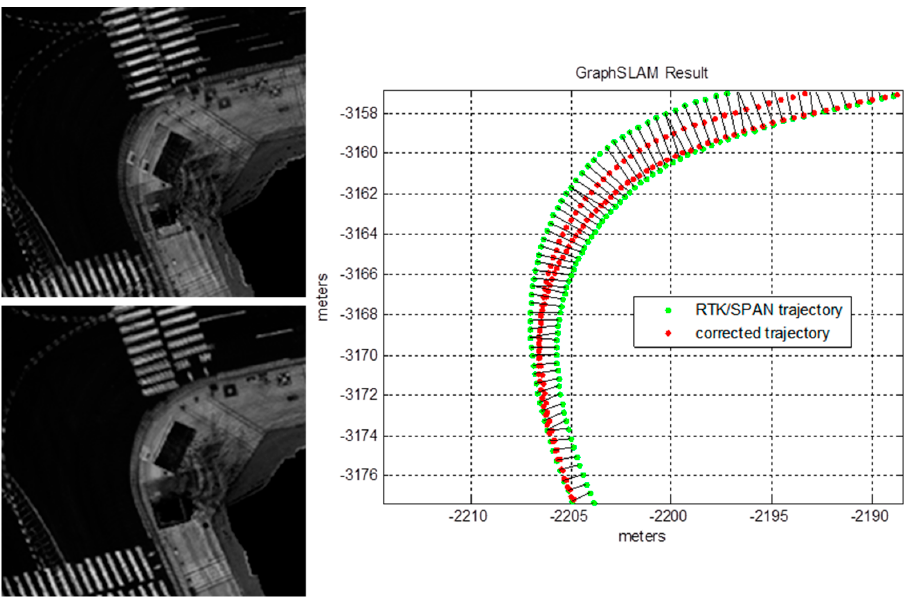
Figure 12. Graph optimization result of the vehicle trajectory using GraphSLAM.